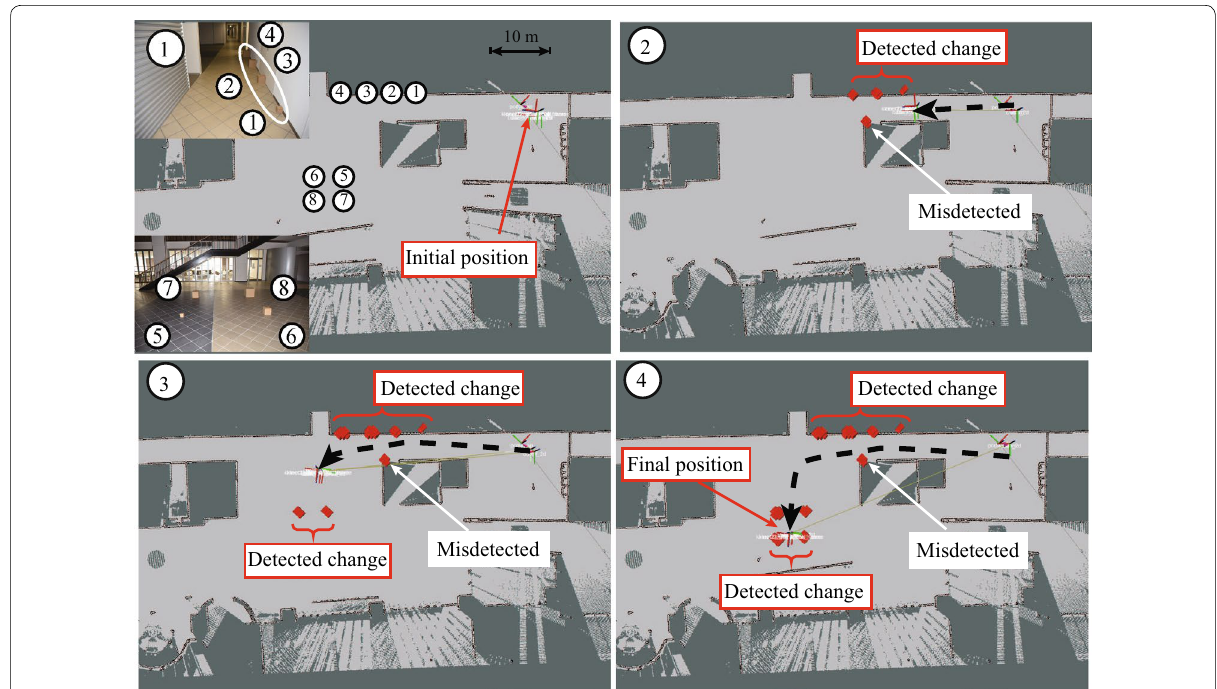
Fig. 10 Detected changes. Four kinds of objects placed at eight positions are correctly detected using the proposed method